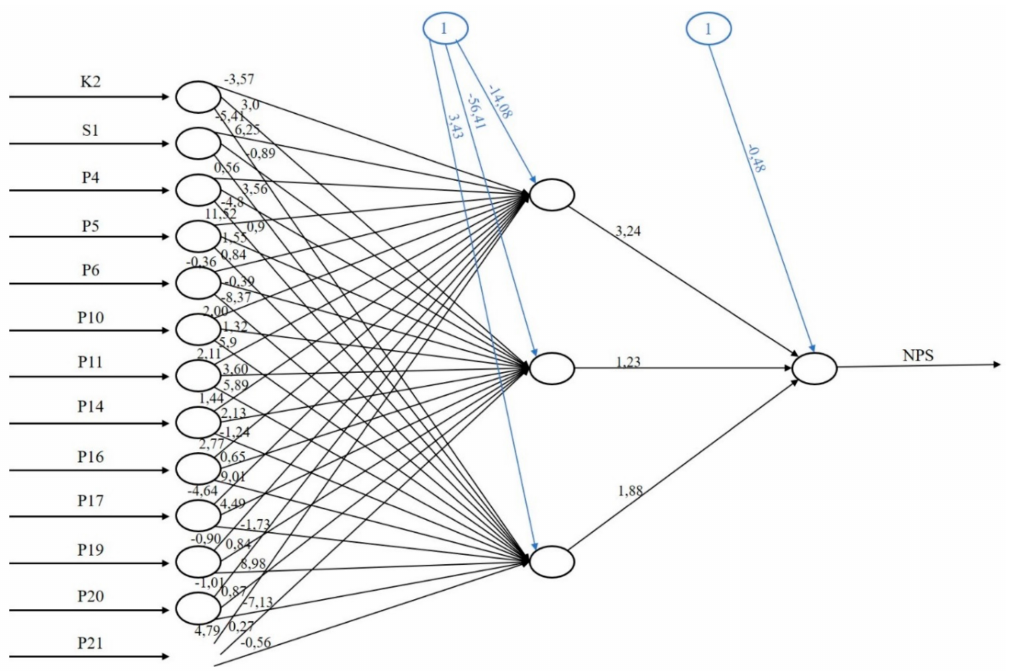
Figure 7. Neural network for the projection of the loyalty of customers by Net Promoter Score (NPS) measure. Source: authors’